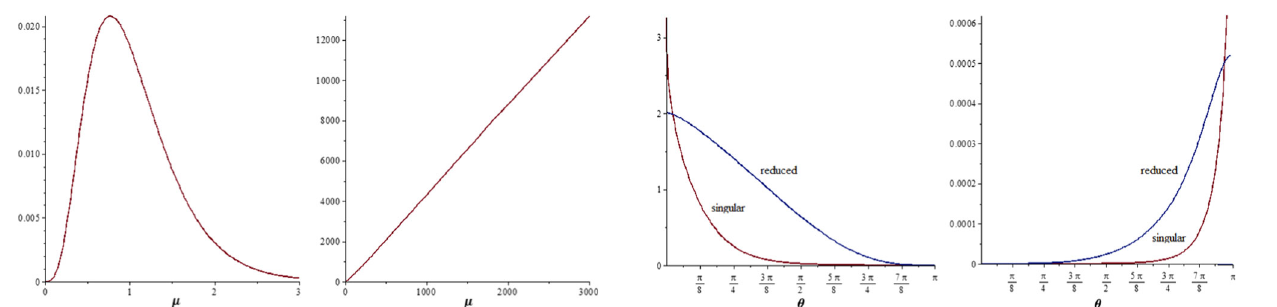
Fig. 1 Functions h (μ) (left panel) and e πμ h (μ) (right panel) ± (μ, θ) and the corresponding reduced p.v.t.s Red Δ σ, − σ